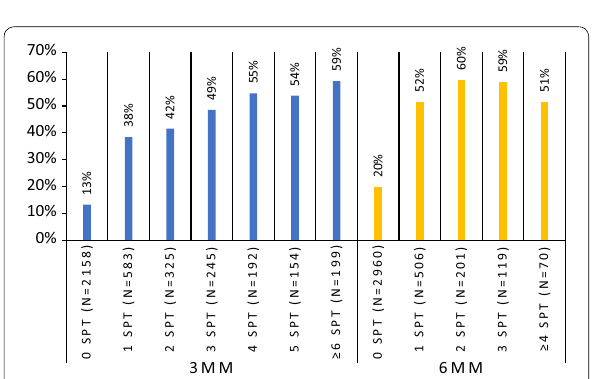
Fig. 2 Percentage of subjects with allergic multimorbidity by the number of positive SPTs (8 groups of allergens). X axis—number of positive allergen skin prick tests. Y axis—% of subjects with allergic